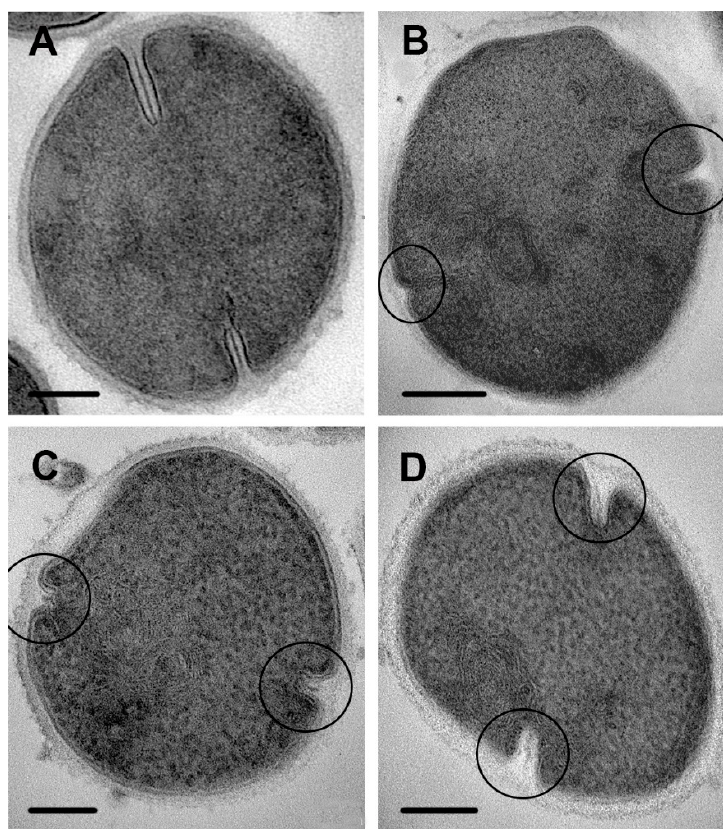
Figure 9. Cells of S. aureus incubated with chlorhexidine. ( A ) control cell; ( B ) 30 min incubation; ( C , D ) 120 min. Ovals show the areas of septum formation, arrows show the deposition of electron-dense material under cell membrane. TEM of ultrathin sections. Scale bars correspond to 200 nm.